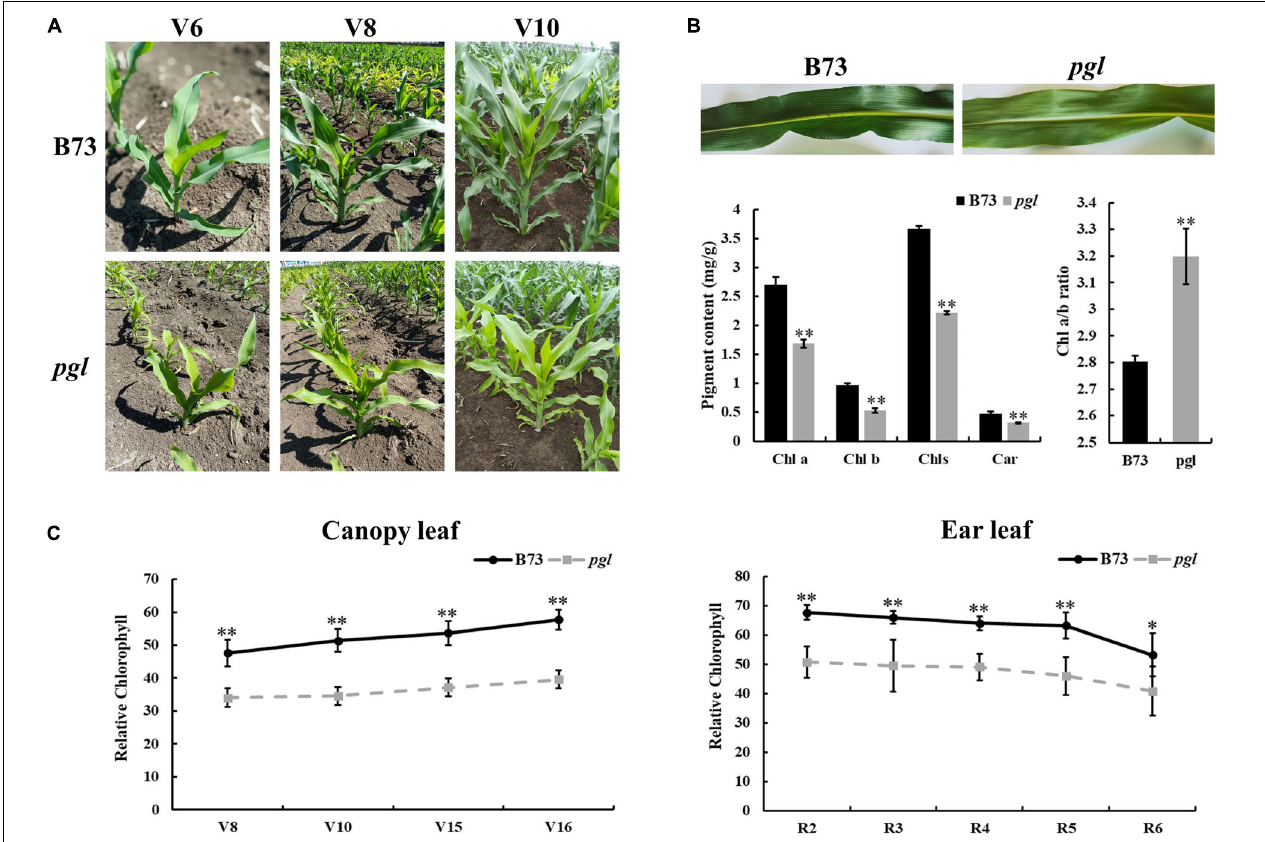
FIGURE 1 | Phenotypic characterization of the pgl mutant. (A) B73 and pgl were observed at different stages. V6, sixth leaf stage; V8, eighth leaf stage; V10, tenth leaf stage. (B) Pigment contents of the third leaf were measured in B73 and pgl using absorption photometry. Seedlings were grown to the third-leaf stage in greenhouse. Data are presented as the means ± SD ( n = 3). (C) Relative chlorophyll content was measured and compared at different stages between B73 and pgl . V15, fifteenth leaf stage; V16, sixteenth leaf stage; R2, blister stage; R3, milk stage; R4, dough stage; R5, dent stage; R6, physiological maturity stage. Data are presented as the means ± SD ( n = 9). Asterisks represent significant differences between B73 and pgl detected by independent sample T test ( ∗ P < 0.05; ∗∗ P <